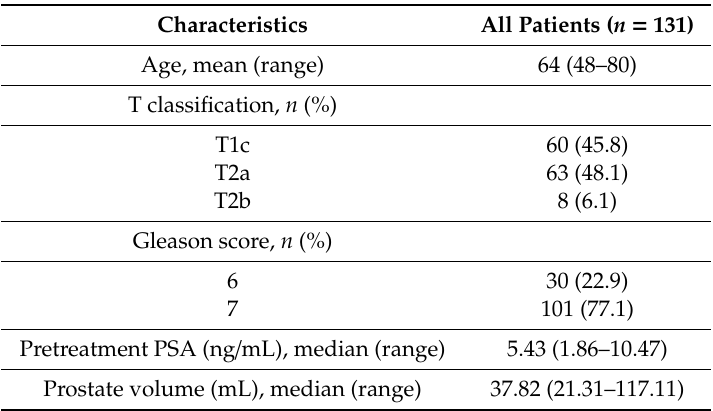
Table 1. Patient